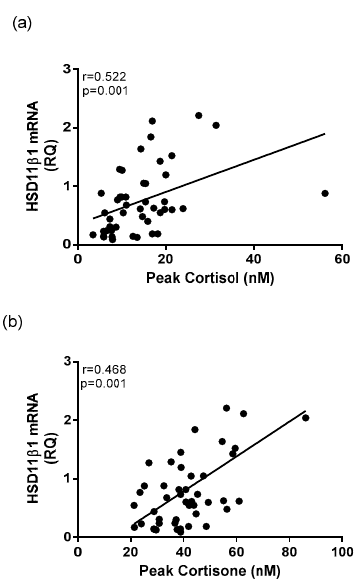
Figure 6. Correlational analysis between whole blood HSD11 β -1 mRNA and glucocorticoid concentrations. A significant positive correlation exists between mRNA expression of HSD11 β -1 and ( a ) peak cortisol concentration and ( b ) peak cortisone concentration.